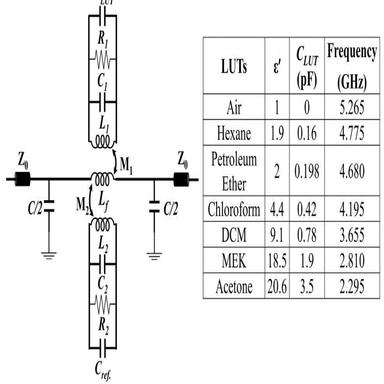
Equivalent circuit of the differential sensor under loaded conditions and CLUT values for loaded samples.